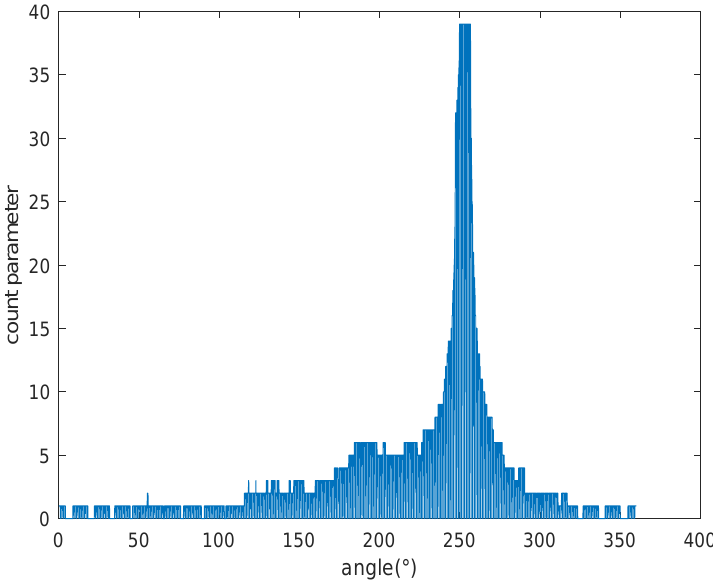
Figure 7. Results of field data of proposed initial position